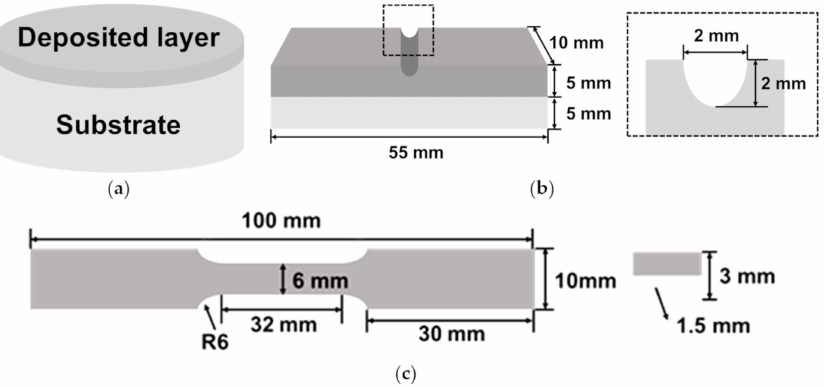
Figure 3. Schematic representation of the specimens for the ( a ) wear test, ( b ) U-notch Charpy impact test and ( c ) tensile